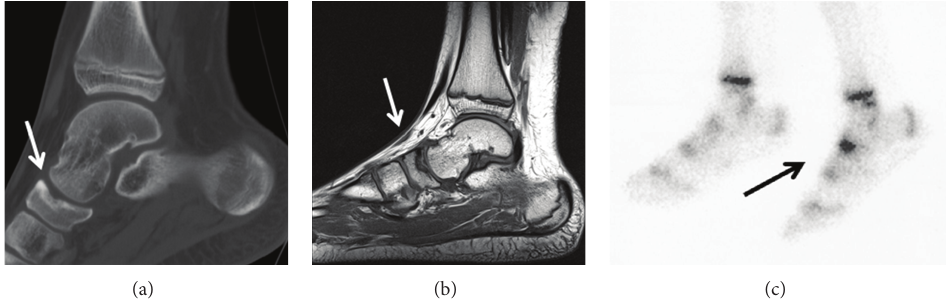
Figure 1: Left foot (a) CT scan: navicular bone indentation and subcortical lesion (arrow). (b) MRI: talonavicular joint effusion and irregularity of the proximal articular surface of the navicular bone (arrow). (c) Osseous scintigraphy: hyperfixation focus at the left navicular bone (arrow).